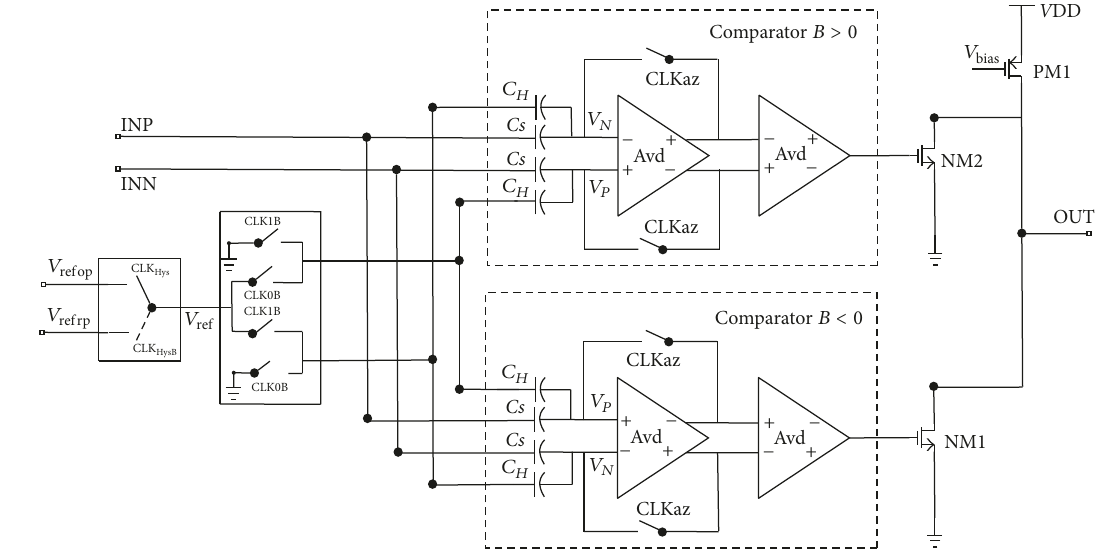
Figure 10: Sampling-hold-compare circuit module.